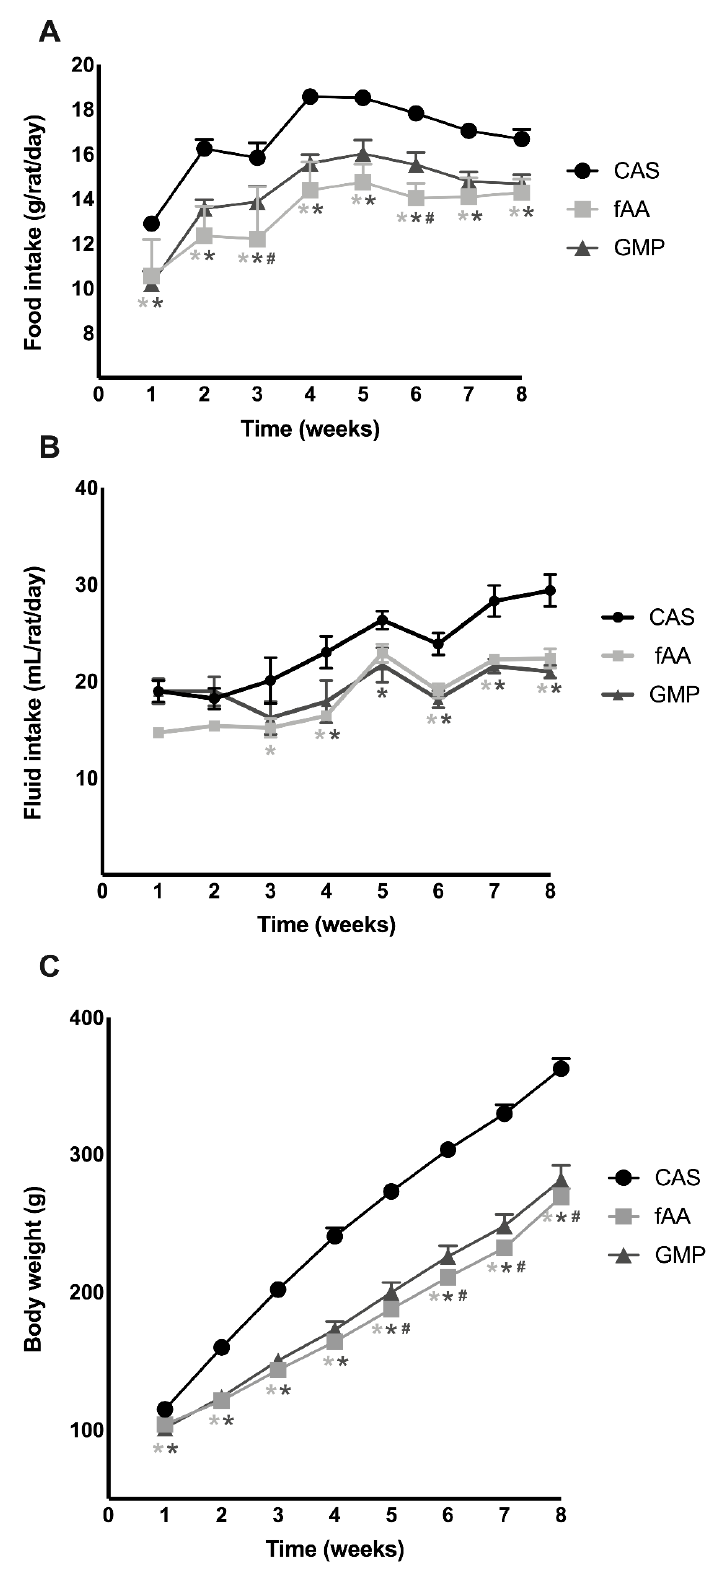
Figure 1. Monitoring of food intake ( A ), fluid intake ( B ) and body weight ( C ) of Wistar rats over the 8-week feeding period. Data are presented as mean ± SEM ( n = 8/group). Two-way ANOVA with repeated measures followed by Bonferroni’s post-hoc test was performed. * p < 0.05 vs. CAS; # p < 0.05 vs. fAA. CAS: casein; fAA: free amino acids; GMP: